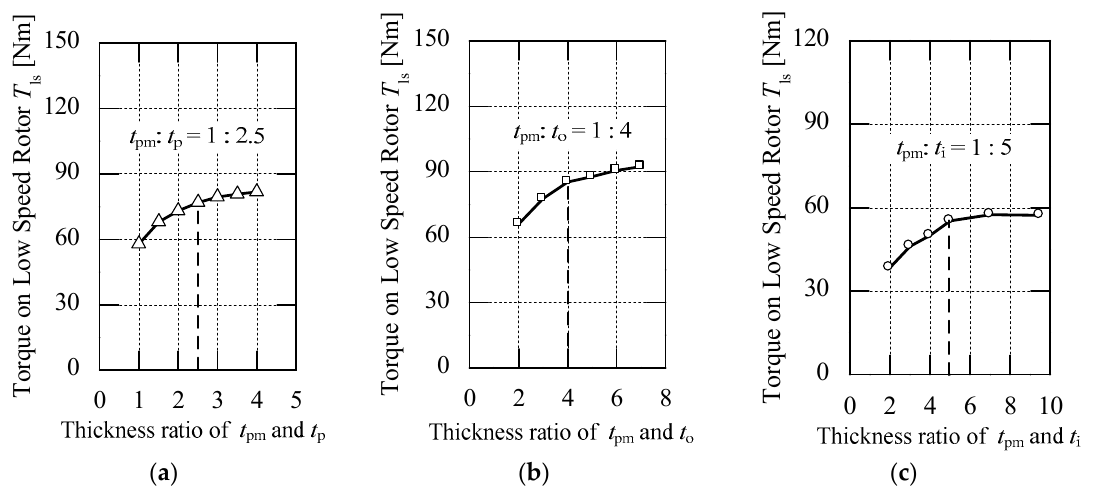
Figure 4. The transmission torque influenced by the thickness ratio of ( a ) t pm and t p , ( b ) t pm and t o and ( c ) t pm and t i .